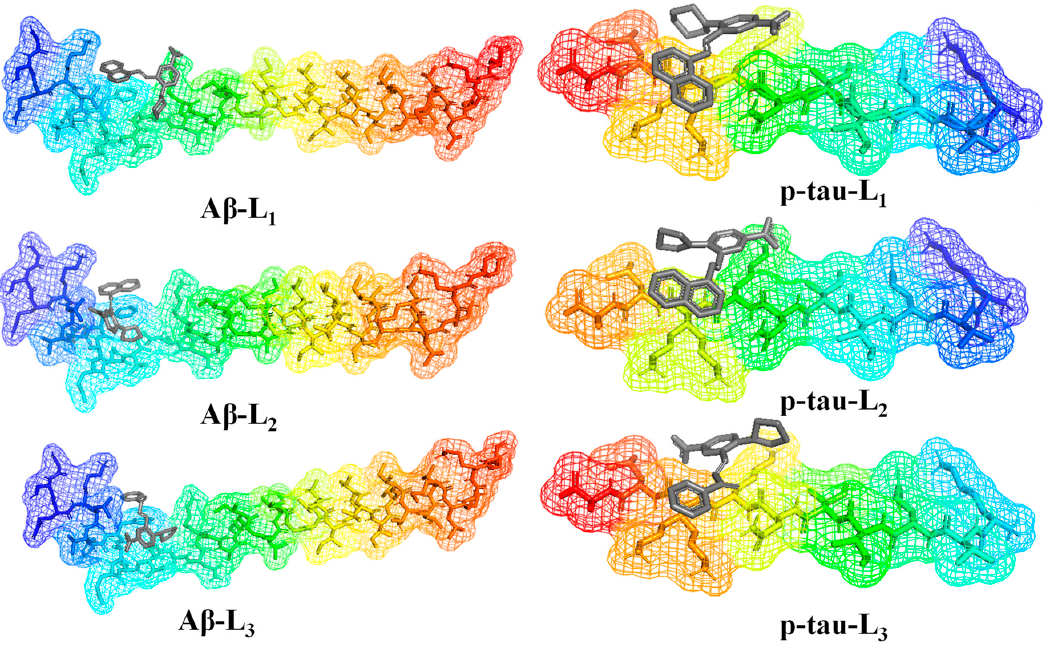
Figure 3. Docking poses of L 1–3 in the binding site of A β and p-tau.